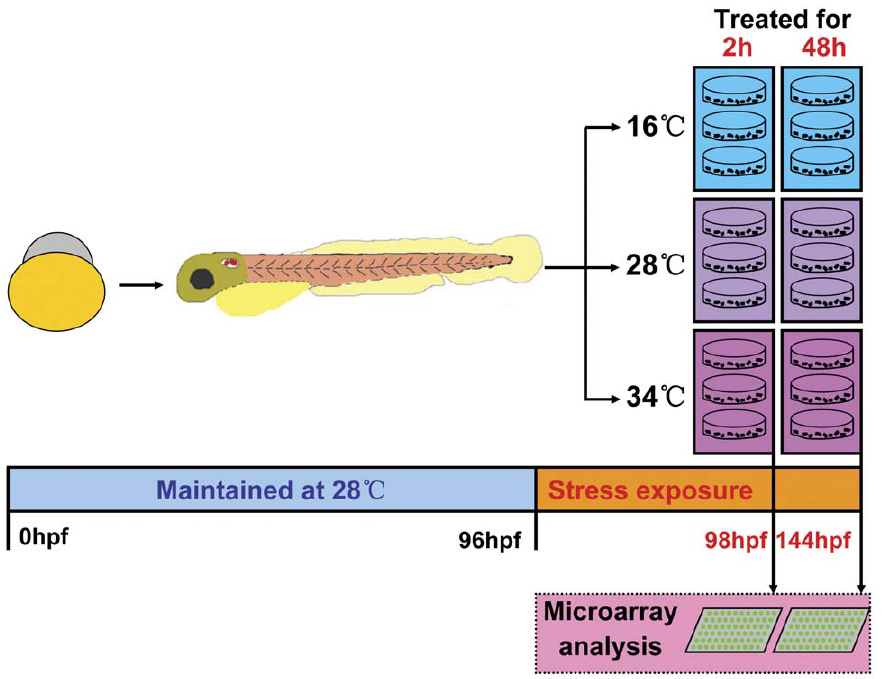
Figure 1. Experimental design. Zebrafish embryos were maintained at 28 u C from fertilization to 96 hpf. Larvae at 96 hpf were exposed to 16, 28 or 34 u C for 2 and 48 h, respectively. Samples exposed to different temperature were collected at 98 and 144 hpf and subjected to microarray analysis.